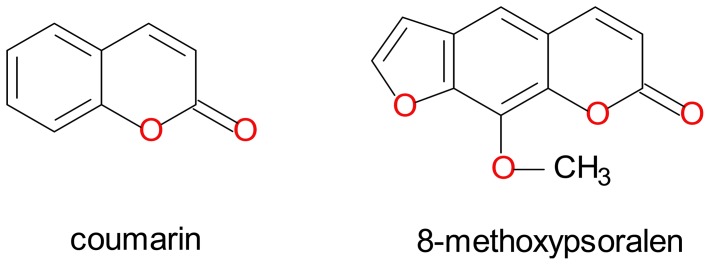
Chemical structures of coumarin and 8-methoxypsoralen.